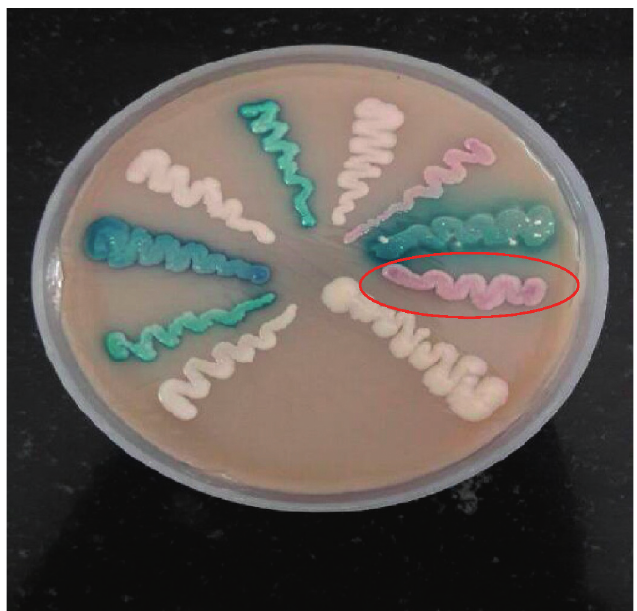
Figure 3: CHROM agar Candida showed the presence of pink mucoid colonies of W. anomalus grown after 48 hours at 37 °